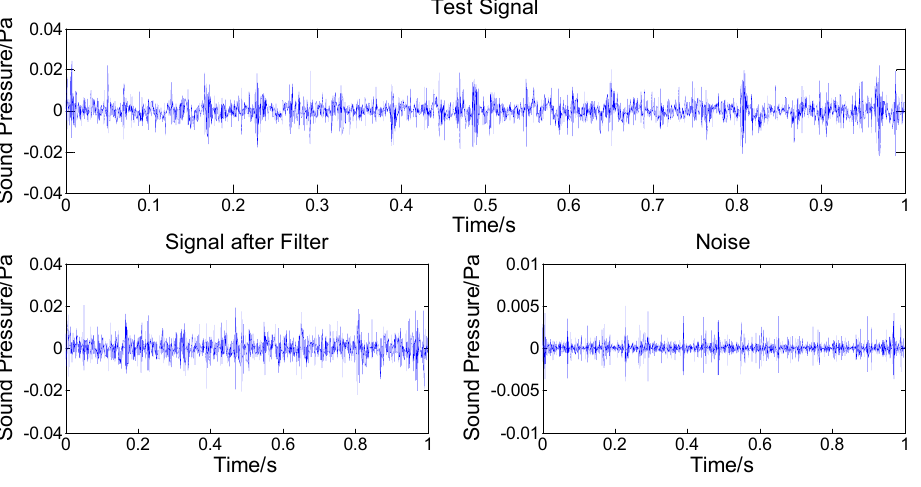
Figure 10. Filter process of signal.